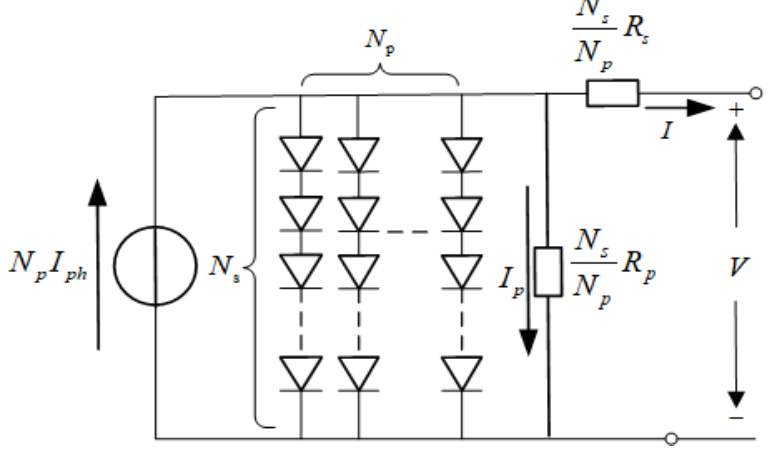
Figure 1. Equivalent circuit of the photovoltaic cell [17–20].